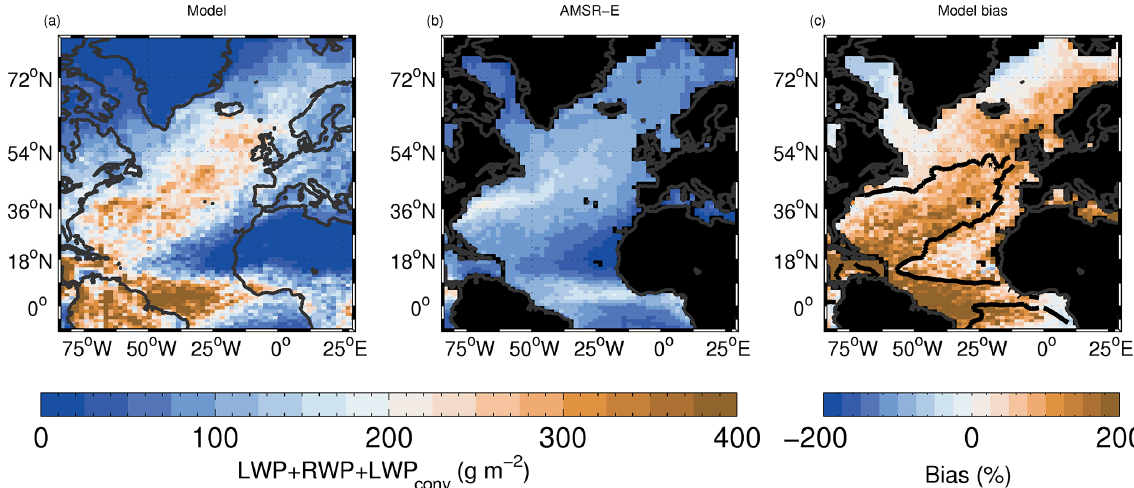
Figure D5. As for Fig. D3 except with the addition of the all-sky LWP from the convection parameterization for the model.